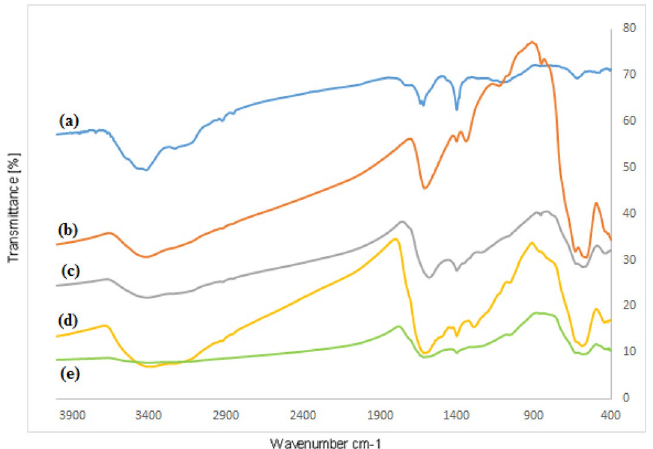
Figure 1. FT-IR spectra of ( a ) GO, ( b ) Fe 3 O 4 , ( c ) GO/Fe 3 O 4 , ( d ) GO/Fe 3 O 4 @PDA and ( e ) GO/Fe 3 O 4